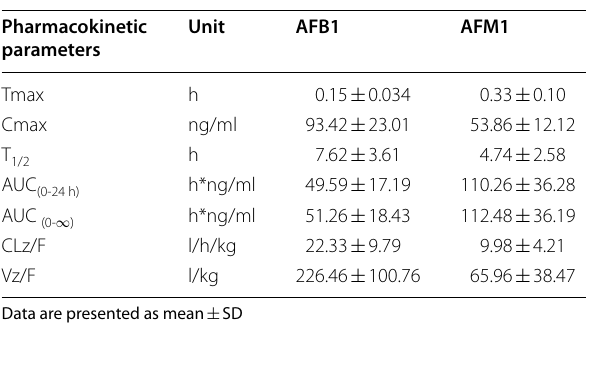
Table 6 Pharmacokinetic parameters using noncompartmental analysis of AFB1 and AFM1 in rat blood after a single oral dose of AFB1